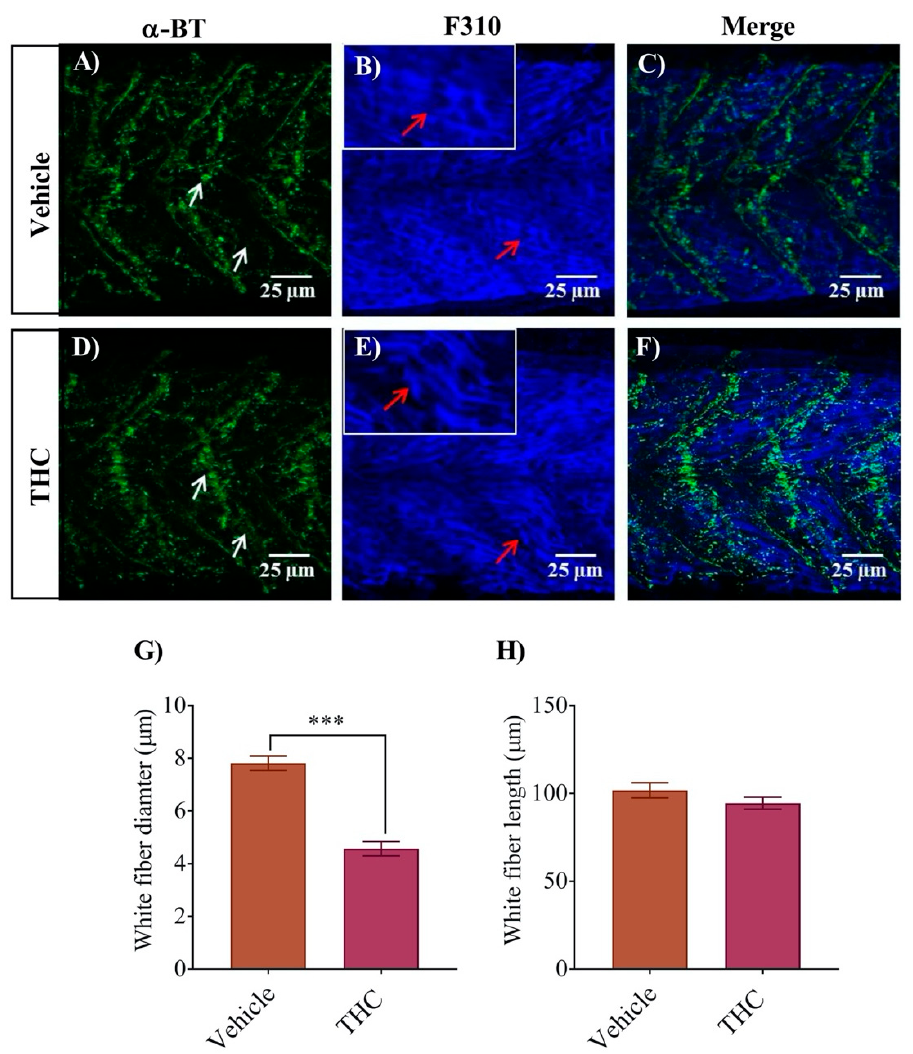
Figure 4. Co-labeling of white muscle fibers and nAChRs using anti-F310 and Alexa 488 conjugated α -bungarotoxin respectively. ( A ) α -Bungarotoxin labelled nAChRs associated with white muscle fibers in vehicle-treated embryos. White arrow shows clusters of nAChRs. ( B ) Anti-F-59 labelled muscle fibers. Red arrows point to the edge of a muscle fiber. Inset shows muscle fibers at higher magnification to better determine the size of the fiber. ( C ) Merged image showing the co-labeled white muscle fiber and nAChR in vehicle-treated animals. ( D ) α -bungarotoxin labelled nAChRs associated with white muscle fibers in THC-treated (6 mg / L) embryos. White arrow shows clusters of nAChRs. ( E ) Anti-F310 labelled muscle fibers. Red arrows point to the edge of a muscle fiber. Inset shows muscle fibers at higher magnification to better determine the size of the fiber. ( F ) Merged image showing the co-labeled white muscle fiber and nAChR in THC-treated animals. ( G ) Bar graph showing the diameter of white fibers for vehicle and THC treated embryos and ( H ) Measurement of white fiber length. *** significantly di ff erent from vehicle control, p < 0.001.